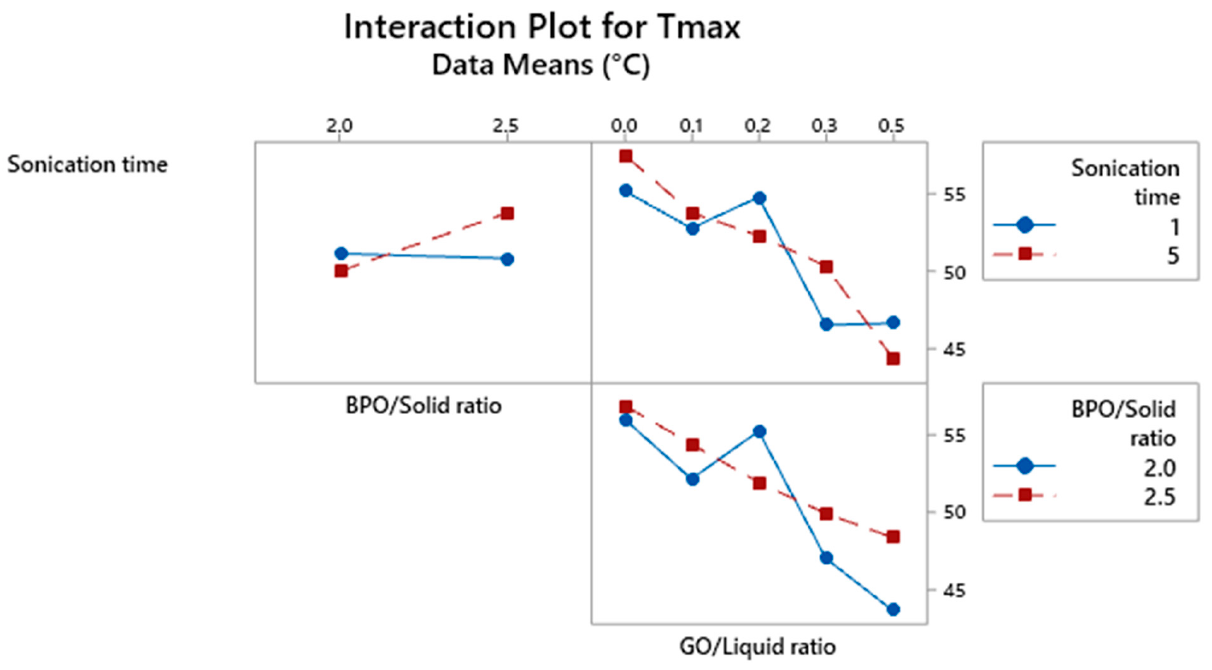
Figure 4. Interaction plot for the variable T max .